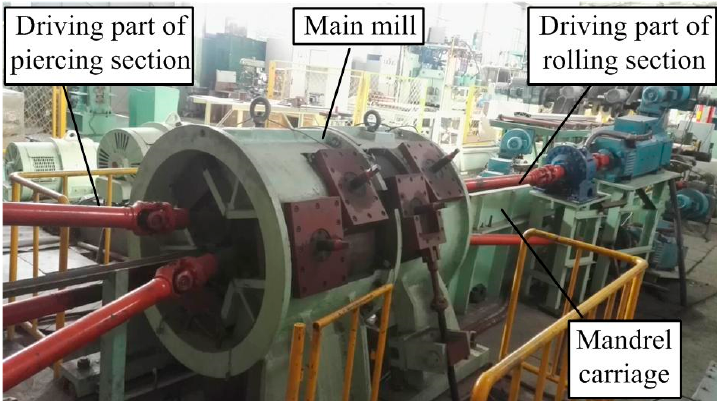
Figure 25. Tandem skew rolling mill [36] (Reprinted from ref. [36]).